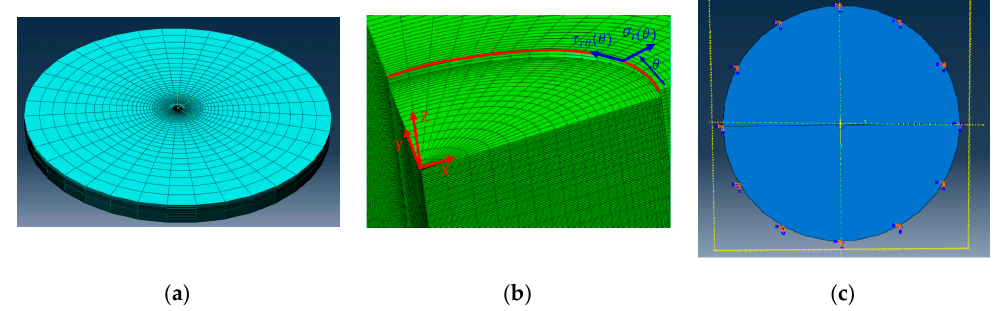
Figure 3. ( a ) ABAQUS finite element analysis (FEA) model used for the calculation of coe ffi cients in the orthotropic material, ( b ) local cylindrical coordinate system for imposing loads at the side surface of the hole and ( c ) mechanical boundary conditions prescribed at the bottom surface of the